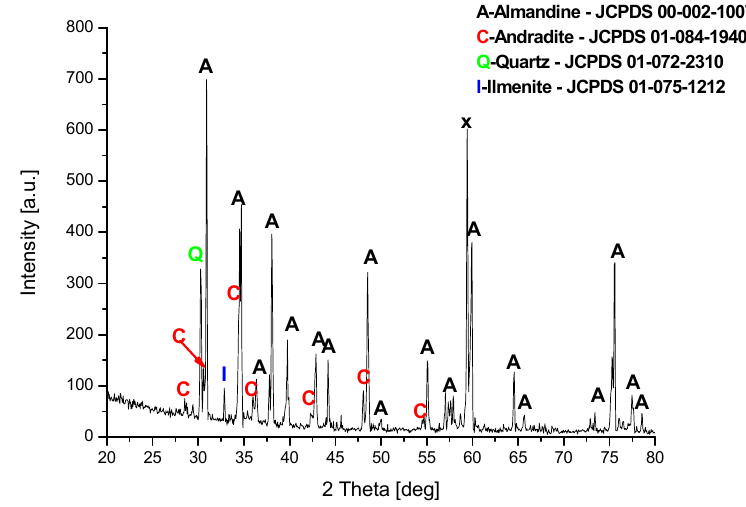
Figure 1. Diffraction patterns of the spent garnet.